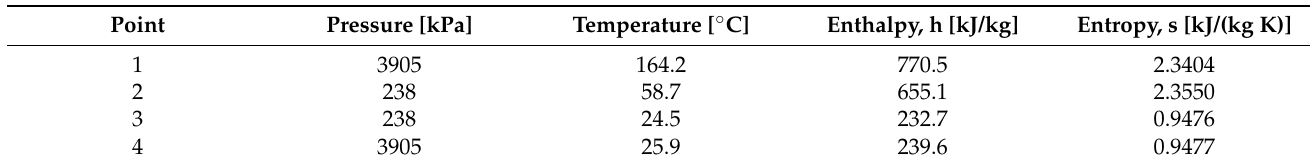
Table 1. Thermodynamic properties of Butane at different locations of the Organic Rankine Cycle (the locations are shown in Figure 1).